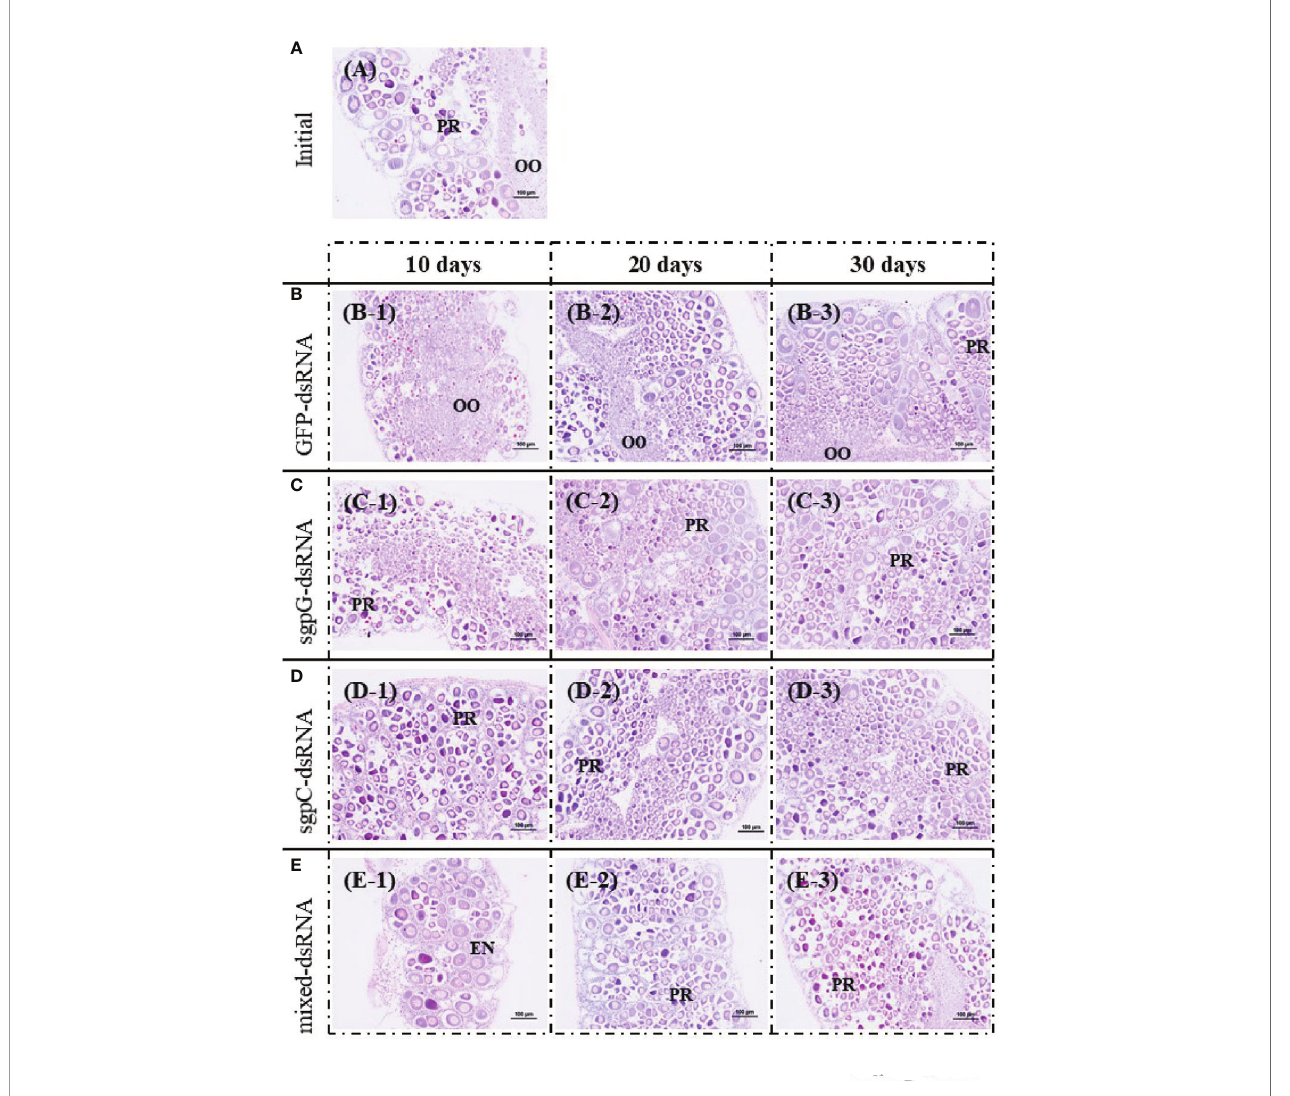
FIGURE 4 | Histological images of oocyte development from representative individuals exhibiting a GSI close to the mean of each group, stained with hematoxylin and eosin. (A) Initial (no injection); A, gonadosomatic index (GSI) = 0.94%. (B) GFP-dsRNA; B-1, 10 days, GSI = 0.33%; B-2, 20 days, GSI = 0.70%; B-3, 30 days, GSI = 1.3%. (C) sgpG-dsRNA; C-1, 10 days, GSI = 0.69%; C-2, 20 days, GSI = 1.1%; C-3, 30 days, GSI = 0.73%. (D) sgpC-dsRNA; D-1, 10 days, GSI = 0.64%; D-2, 20 days, GSI = 0.82%; D-3, 30 days, GSI = 0.65%. (E) Mixed-dsRNA; E-1, 10 days, GSI = 0.64%; E-2, 20 days, GSI = 0.77%; E-3, 30 days, GSI = 0.62%. Oocyte developmental features: OO, oogonium; PR, previtellogenic oocytes; EN, endogenous vitellogenic oocytes. Bars = 100